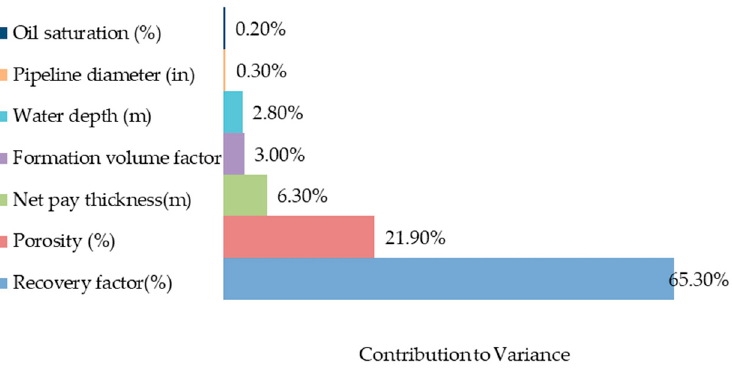
Figure 7. Sensitivity analysis of parameters under low oil price.